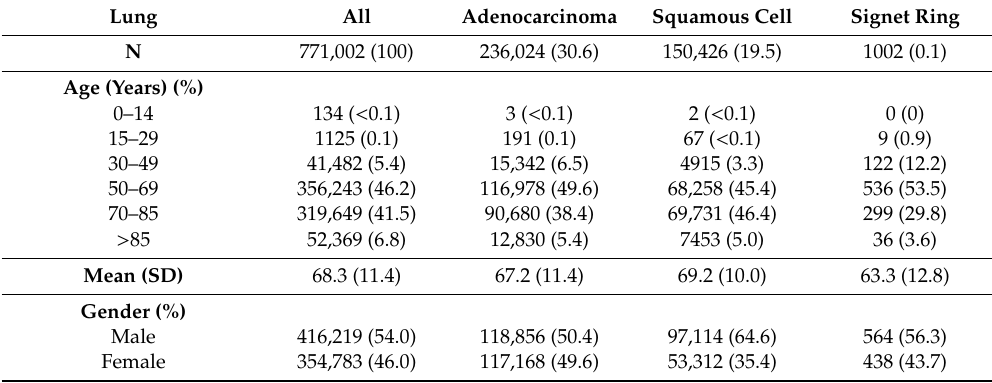
Table 9. Baseline demographics and clinical characteristics by histology for lung